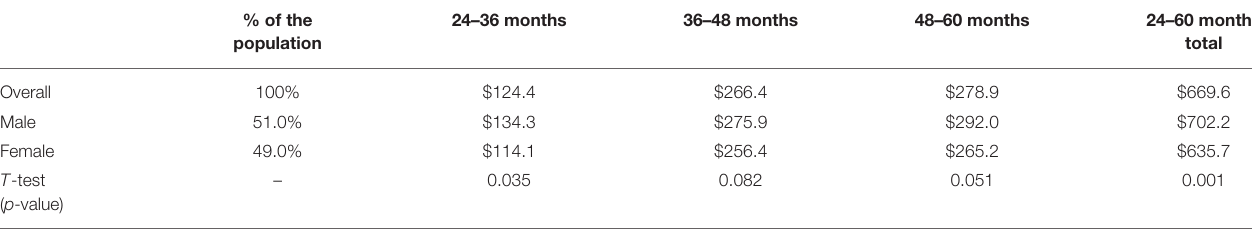
TABLE 1 | The mean of Per Member Per Year (PMPY) dental cost and the total cost of each demographic subgroup (Total N = 24,223).